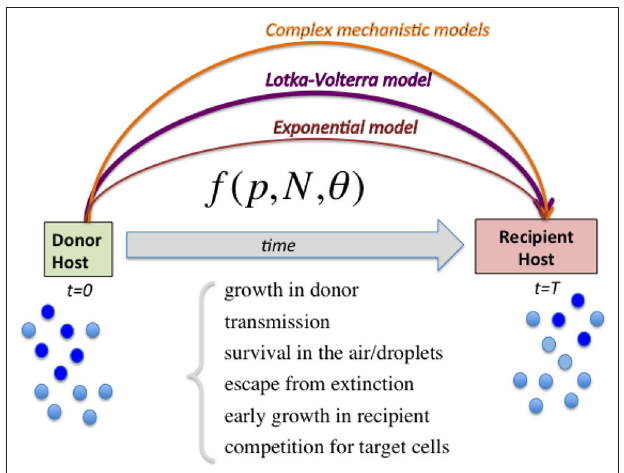
FIGURE 1 | Diagram illustrating the range of models to capture relative fitness differences between strains at the growth-transmission interface. Linking the measured strain frequencies in the donor host ( p ) to the observed strain frequencies in recipient host after transmission, requires the specification of a model (here abstractly denoted by the function f ) encapsulating multiple biological processes, and parameters encoding strain phenotypes θ as well as population size of viral load N . In order to harness the full information in competitive-mixture experiments (e.g., Hurt et al., 2010), alternatives to the purely exponential model for evaluating relative fitness between strains can be the Lotka-Volterra model formulation, as we advocate here, as well as more sophisticated models encoding explicit infection life-history traits. Complex models can capture more ecological scenarios, including bistability and coexistence, which lead to different predictions for within-host vs. between-host diversity in strain prevalences, and are likely to explain a wider range of epidemiological